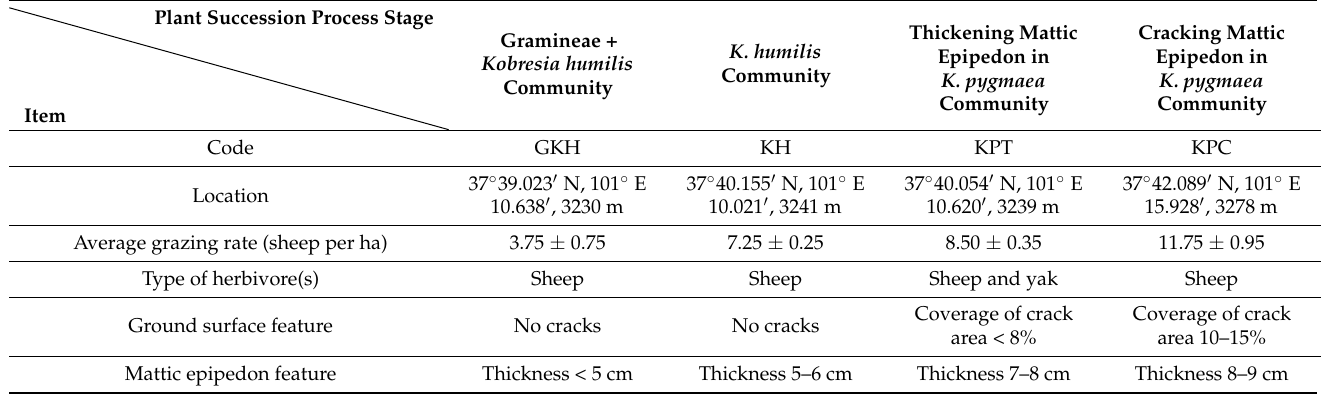
Table 1. General overview of the study sites.